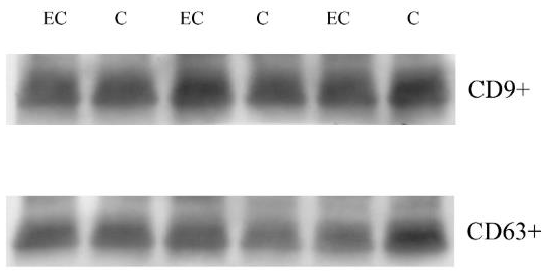
Figure 1. CD 63 and CD9 common exosome markers. Western blotting in exosome of three C (control) and three EC (endometrial cancers). Table 1. Different abundance proteins identified by mass spectrometry in EC compared to the control serum